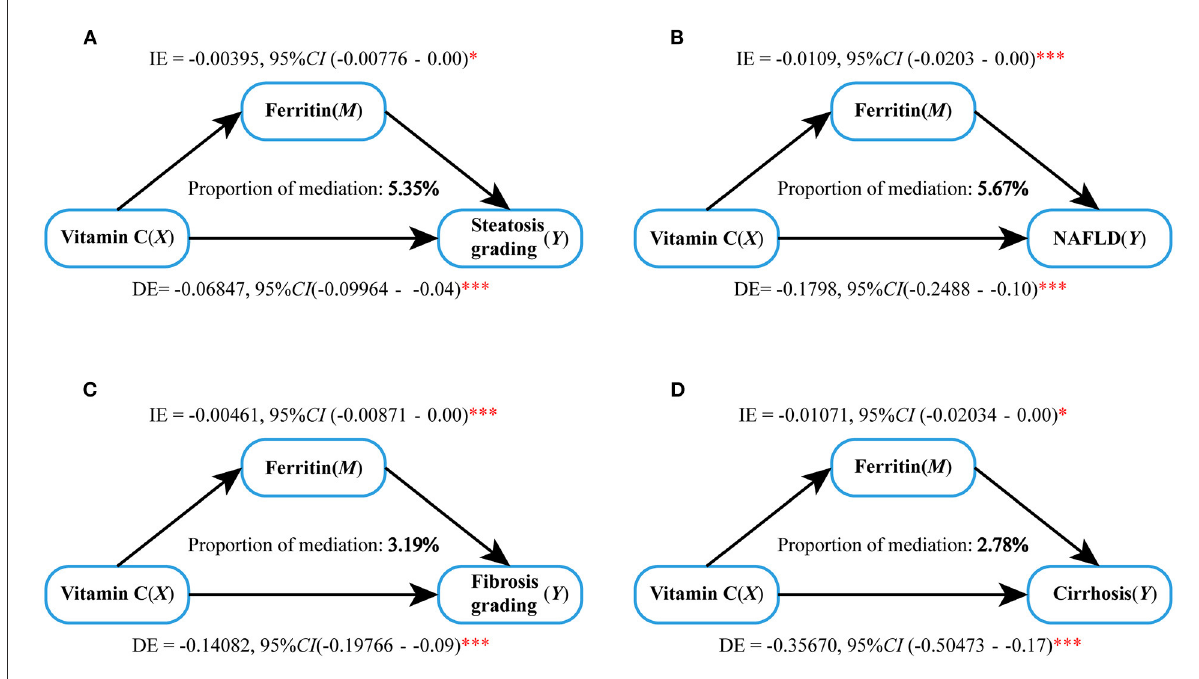
FIGURE3 Mediation analysis of serum ferritin on the interaction between Vitamin C and prevalence of NAFLD and cirrhosis. (A) Steatosis grading, (B) NAFLD, (C) fibrosis grading, and (D) cirrhosis. * p < 0.05, *** p < 0.001.